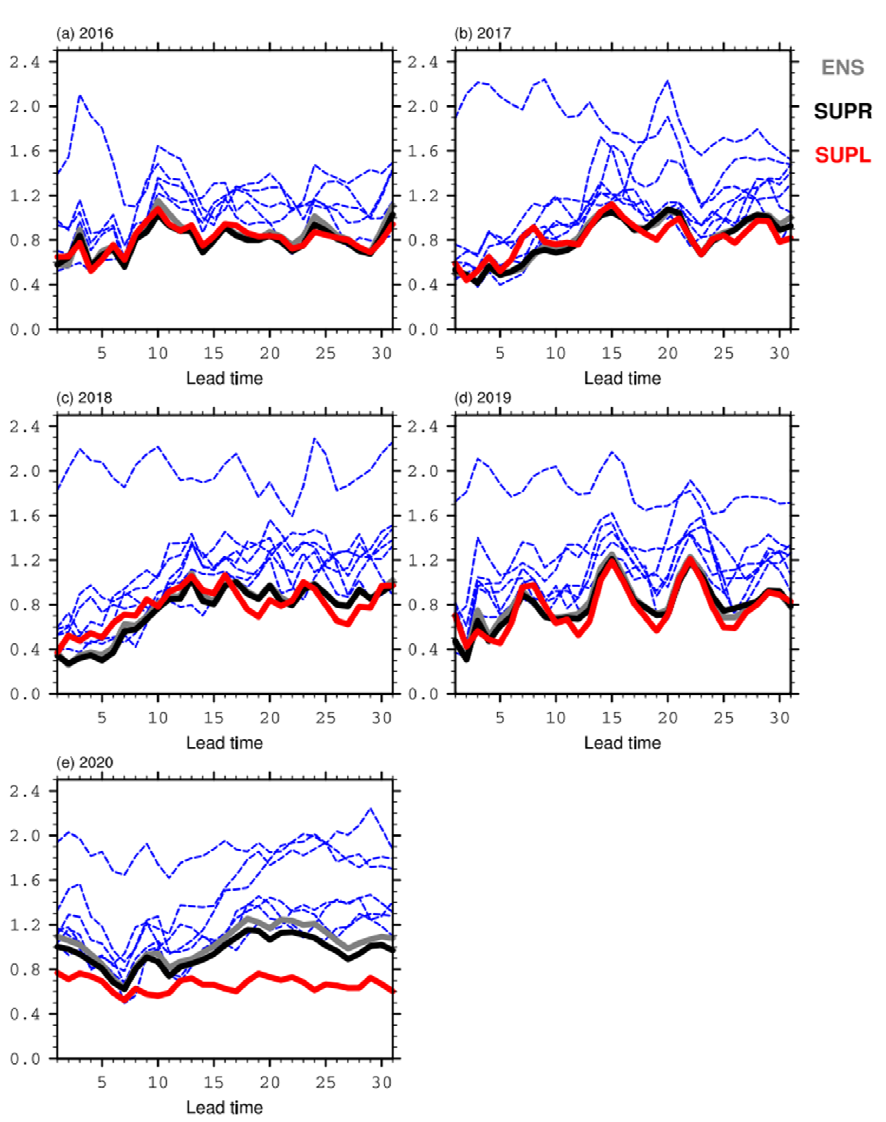
Figure 2. Variation in RMSE at the initial 1–17 days derived from seven models (blue lines) and the ensemble forecasts of ENS (grey line), SUPR (black line), and SUPL (red line) in ( a ) 2016, ( b ) 2017,